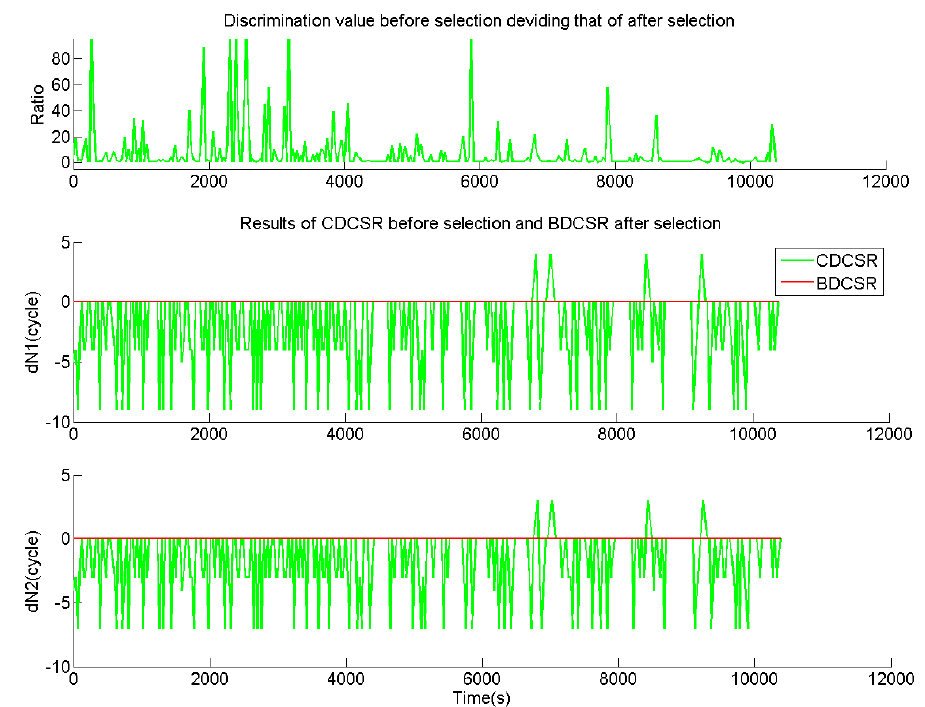
Figure 12. Results of conventional dual-frequency CSR (CDCSR) before selection and BDCSR after selection via the discrimination function in the case of appending gross errors of 0.7 m on all real epoch-difference pseudoranges from MEO Satellite 11 under a weak condition of low elevations during the geomagnetic storm, where the phase data without cycle slip was collected at the CUT0 station started from UTC 8 May 2016 00:00:00 with an interval of 30 s.